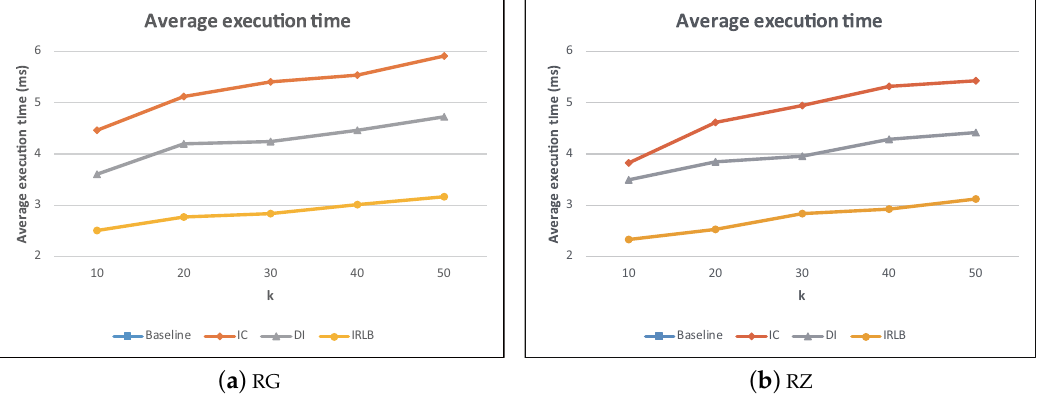
Figure 26. Average execution time vs. k